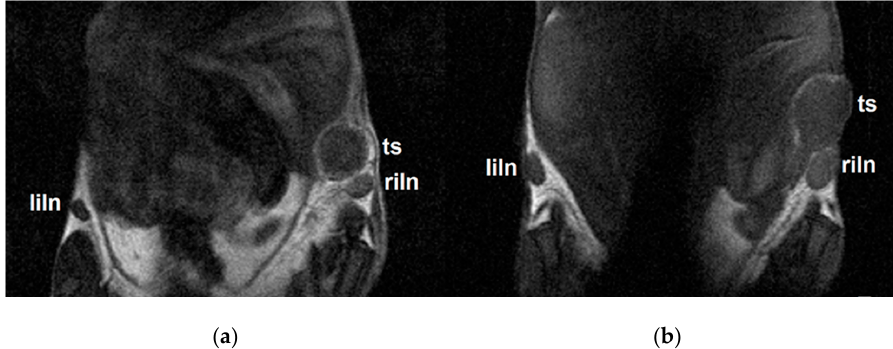
Figure 5. Representative coronal MR images measured three days after the injection of ( a ) MN or ( b ) MNOX into the right thigh muscle. Left inguinal lymph nodes (liln), tumors (ts) and right inguinal lymph nodes (riln) represent sites of polymer accumulation.